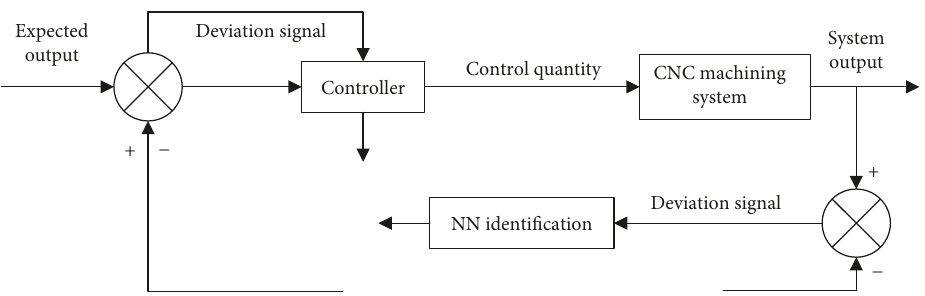
Figure 5: Basic principle of nanomaterial neural network numerical control system.